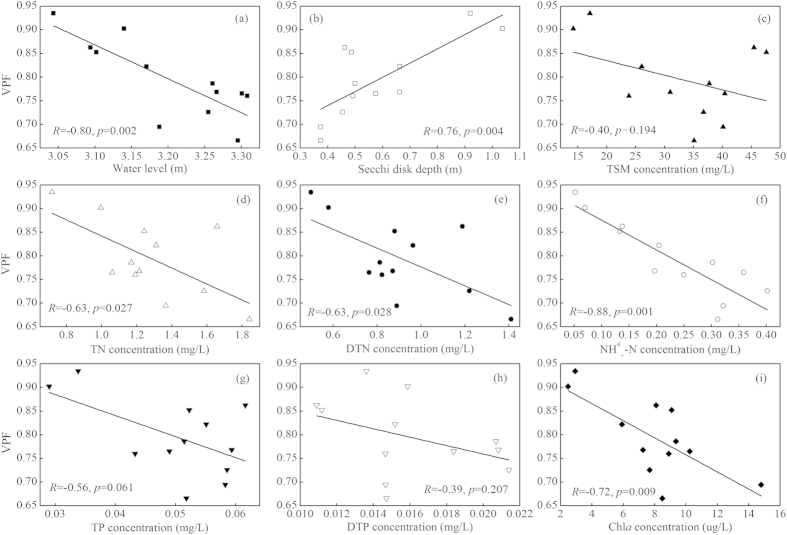
Linear relationships between WL (a), SDD (b), TSM (c), TN (d), DTN (e), NH4+-N (f), TP (g), DTP (h), and Chla (i) concentrations and the VPF.